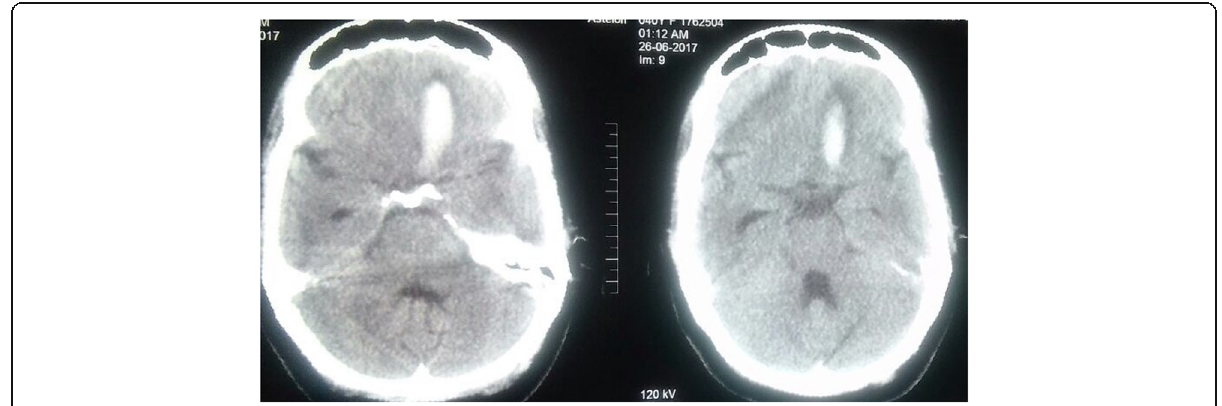
Fig. 1 CT scan of the patient showing hematoma in the left gyrus rectus